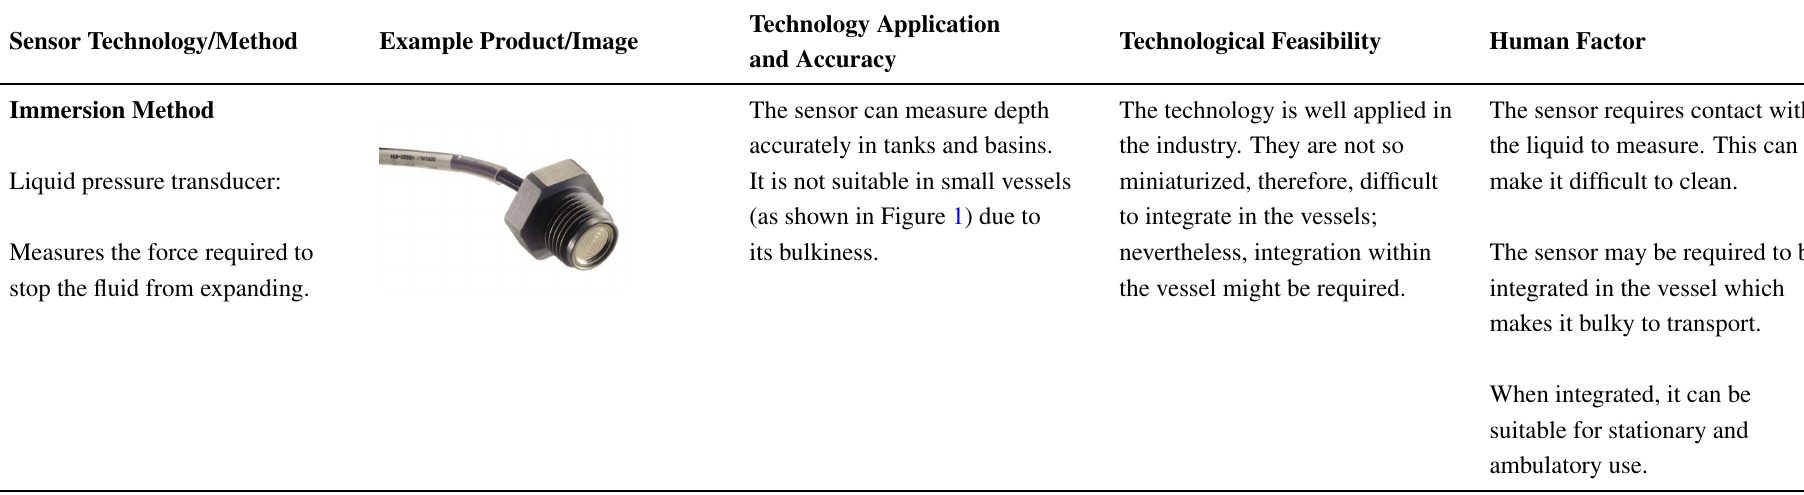
Table 1. An overview of sensor technologies applicable to monitor water/fluid